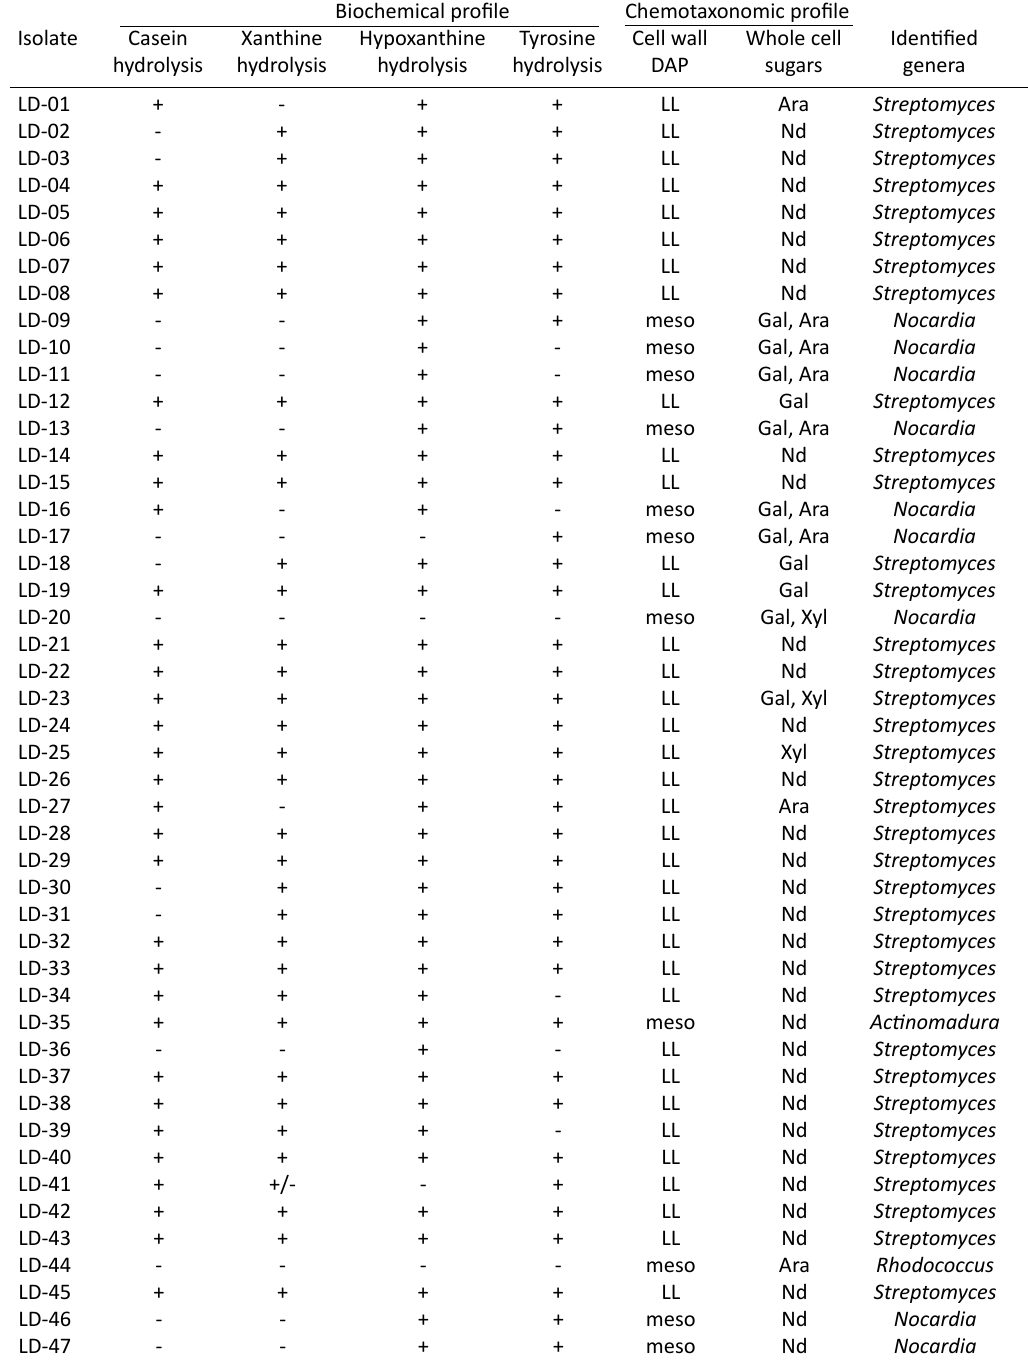
Table 1. Biochemical and chemotaxonomic profile of actinobacterial isolates from the limestone mining site